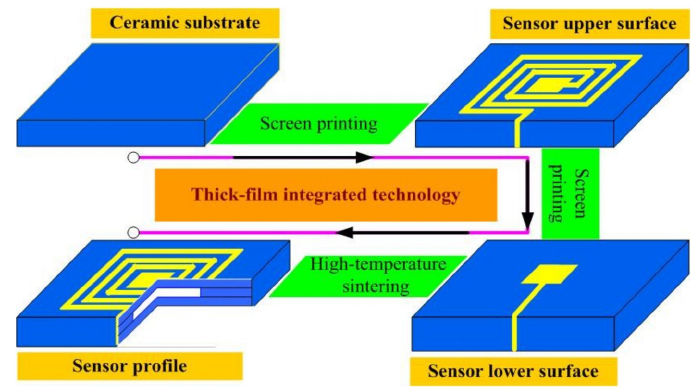
Figure 3. Post-fire metallization of the fabricated alumina ceramic sensitive cavity.